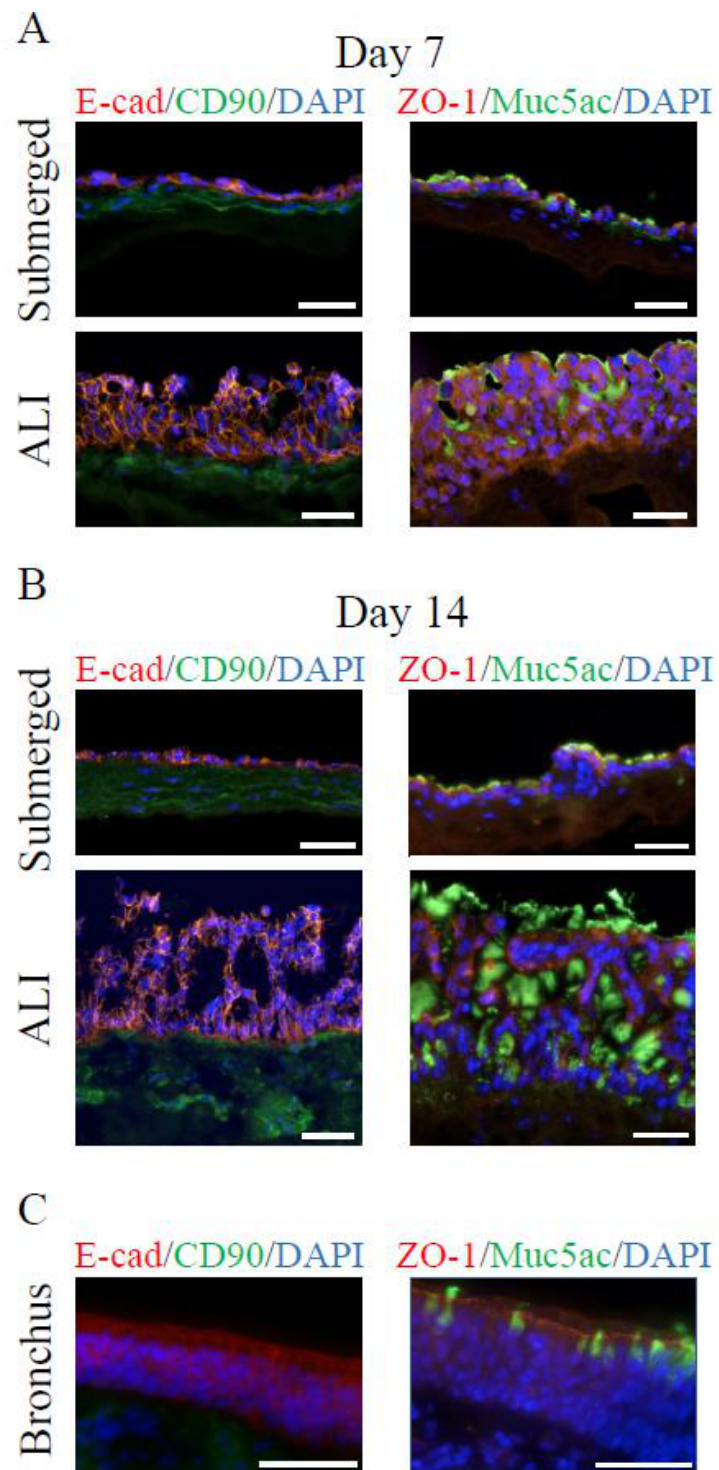
Figure 2. In 3D airway tissue models, tight junctions form, and mucus-producing cells are present. ( A ) Immunofluorescence characterization of 3D submerged and ALI models after 7 days, ( B ) 14 days of cultivation, and ( C ) native bronchial epithelium. Antibody stainings against E-cadherin (E-cad, epithelial cells, red), CD90 (fibroblasts, green), ZO-1 (tight junction marker, red), and Muc5AC (secreted mucus protein, green). Nuclei were stained with DAPI (blue). Three independent experiments were performed. Scale bars represent 50 µm.